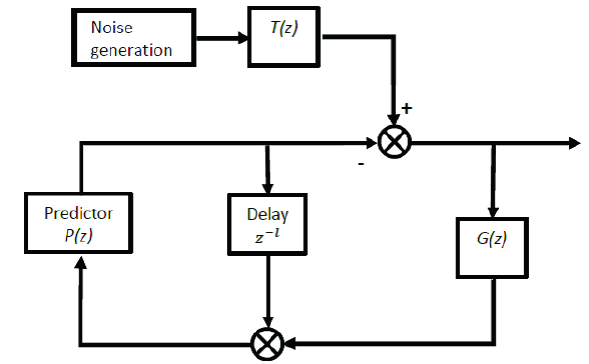
Fig. 5: Feedback noise